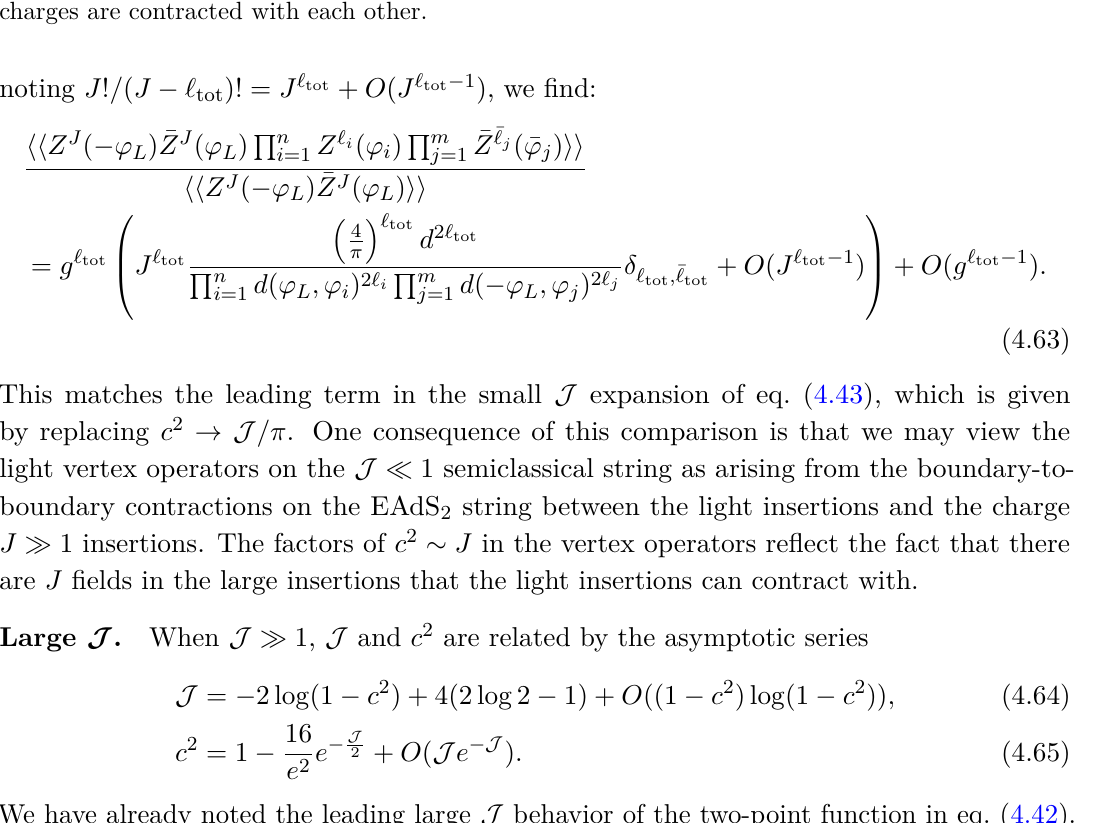
Figure 6 . In the planar and strongly coupled regime, the leading behavior (in 1 /g ) of the defect correlators of operators with parametrically small charges can be analyzed using the free theory on the EAdS classical string dual to the Wilson loop without insertions. When two of the operators 2 have a large charge, 1 (cid:28) J (cid:28) g , the leading contributions (in 1 /J ) come from diagrams in which the light operators are fully contracted with the large charges, and the remaining fields of the large charges are contracted with each